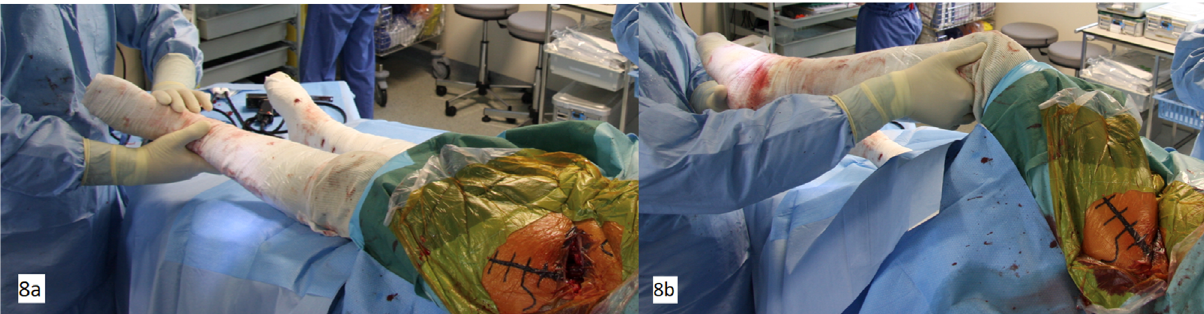
Figure 8. The surgeon can assess the anterior stability in extension and external rotation (a), the range of motion and an eventual impingement (b).